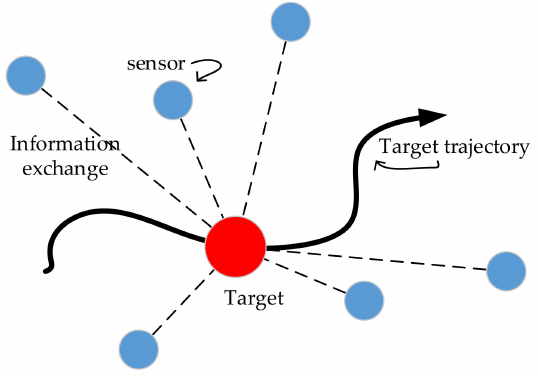
Figure 2. Filter-based target tracking and positioning